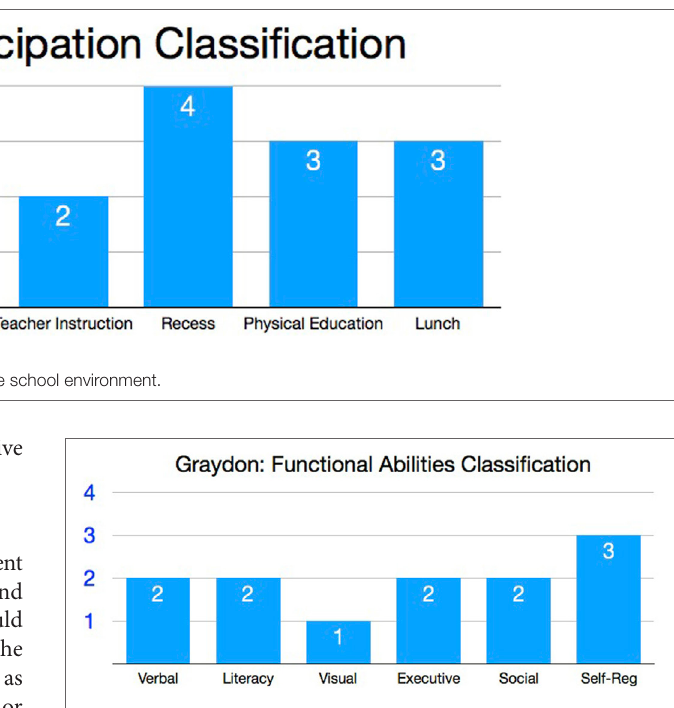
FigUre 2 | “Graydon”: classification of functional ability